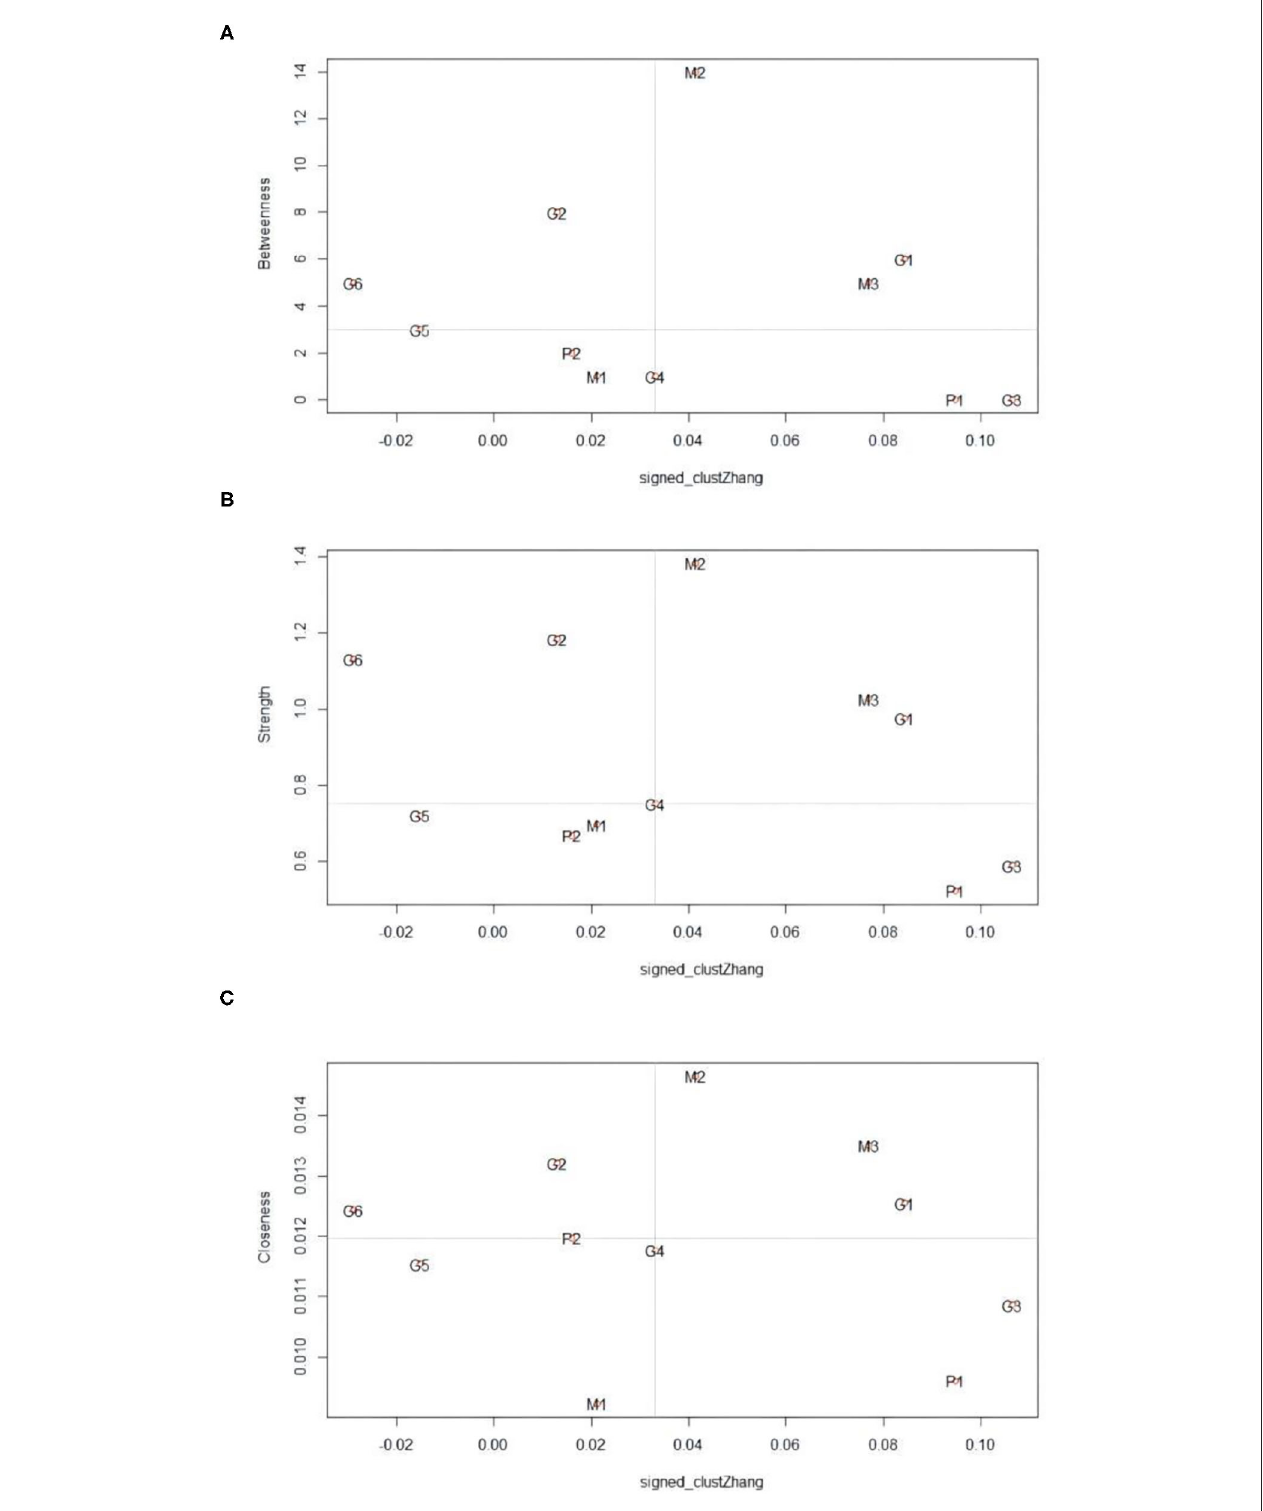
FIGURE 5 | The relationship between the centrality of the topic network and the clustering coefficient in Weibo.